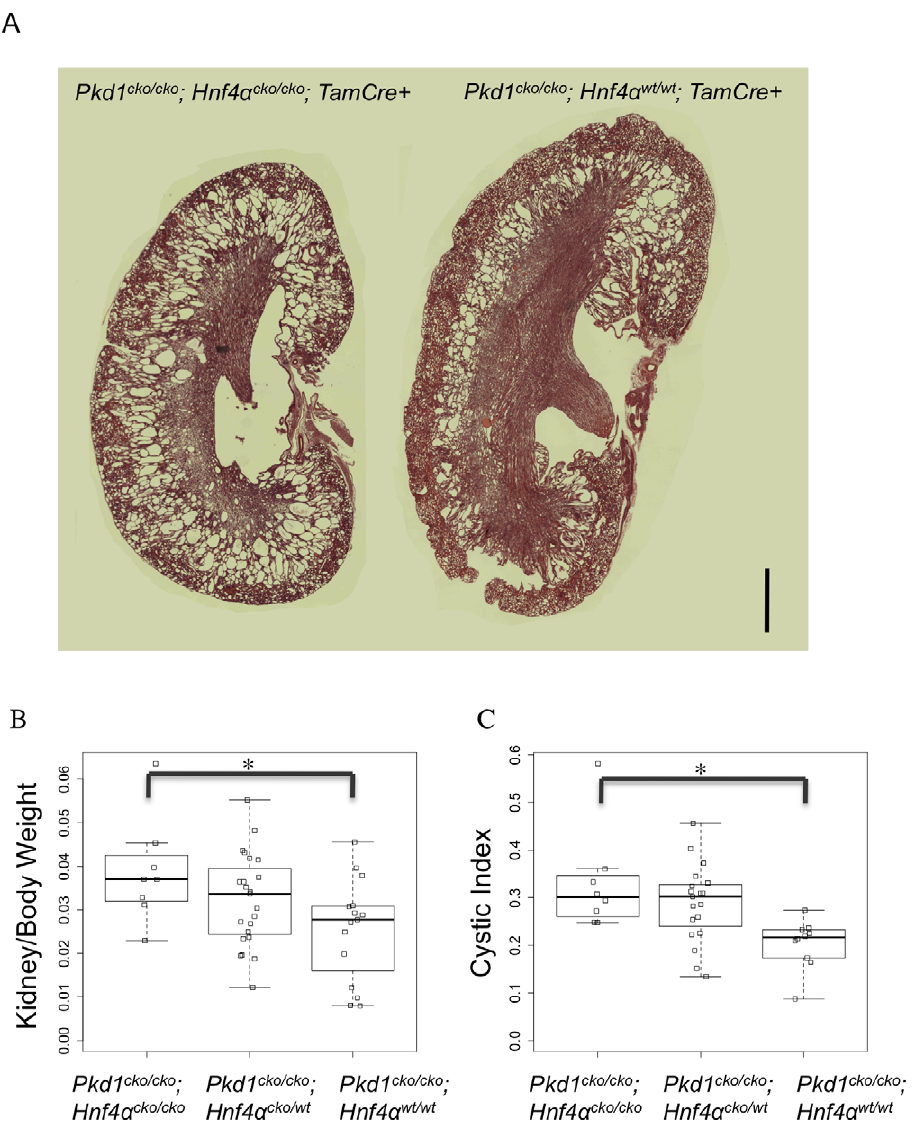
Figure 5. Hnf4 a is a modifier of Pkd1 -cystogenesis. (A) Representative kidney histology of Pkd1 cko/cko ; Hnf4 a cko/cko ; Tamoxifen-Cre + (left) and Pkd1 cko/cko ; Hnf4 a wt/wt ; Tamoxifen-Cre + (H&E stain; scale bar: 1000 mm). (B and C) Boxplot of kidneys/(2*body weight) (B; 95% confidence interval: 0.0021 to 0.0245, p=0.02271) and cystic index (C; 95% confidence interval: 0.0334 to 0.2304, p=0.01311; blank squares: samples).